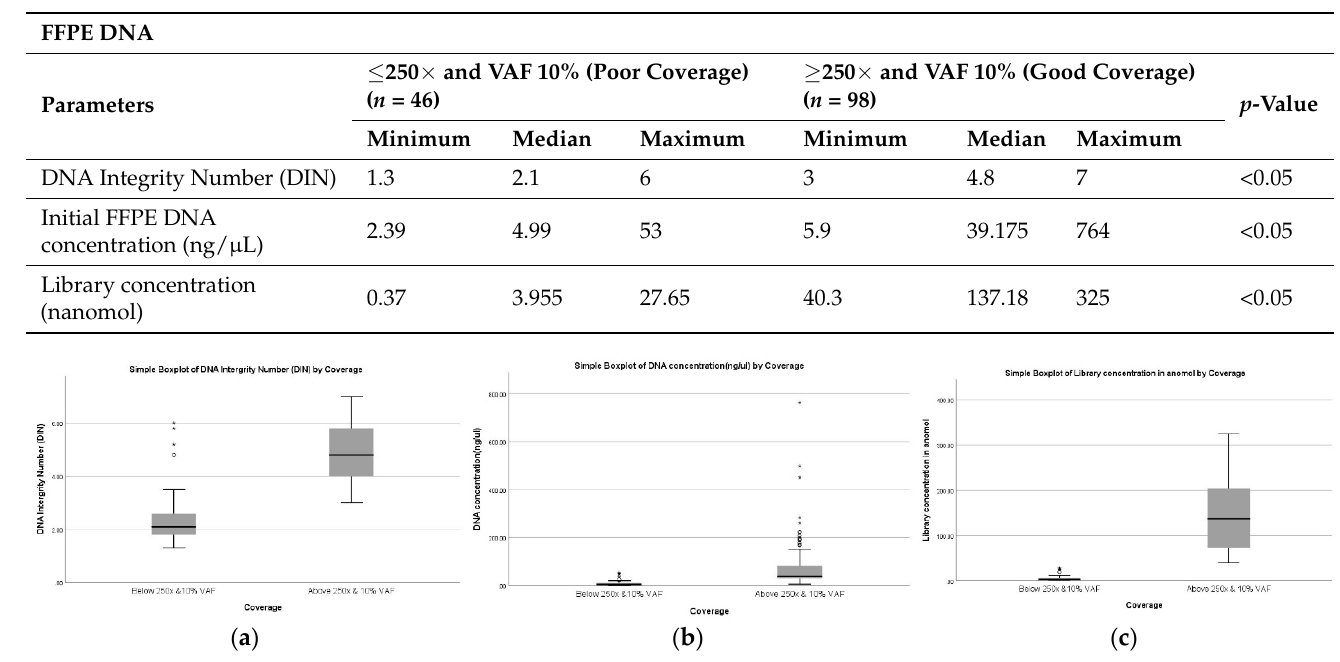
Table 1. Sample characteristics of FFPE DNA according to NGS coverage.